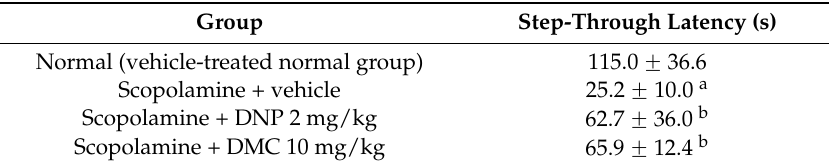
Table 1. Effect of demethoxycurcumin (DMC) on scopolamine-induced memory impairment in the passive avoidance